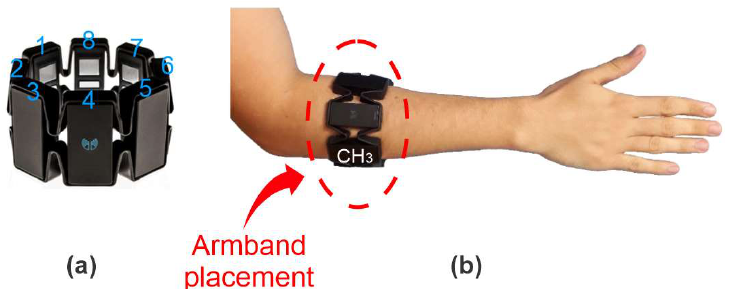
Figure 2 . ( a ) Commercial Myo TM device used for data acquisition with the numbers of its respective channels. ( b ) Placement of the armband on the subjects’ forearm. The reference (channel 3) was placed on the flexor carpi ulnaris to make all acquisitions uniform.